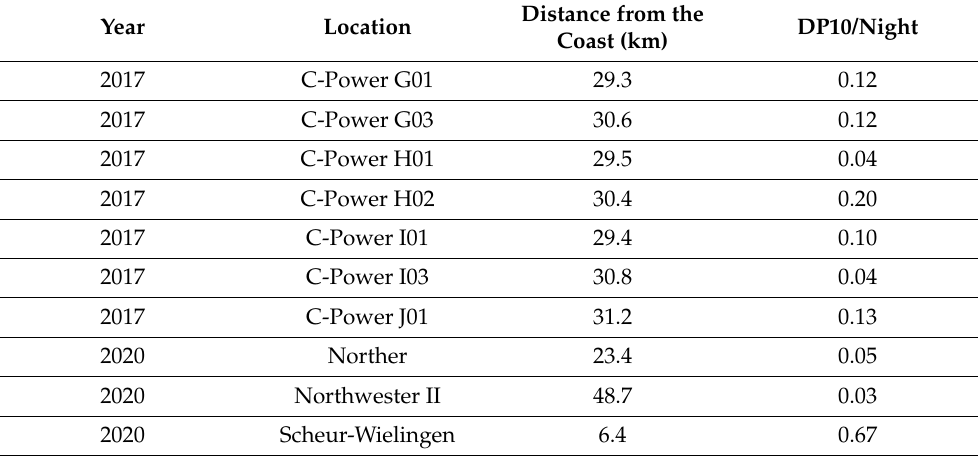
Table 2. Detection positive ten minutes (DP10) per night, per acoustic detector during the 2017 and 2020 surveys. Each location in the C-Power wind farm represents a turbine with its unique